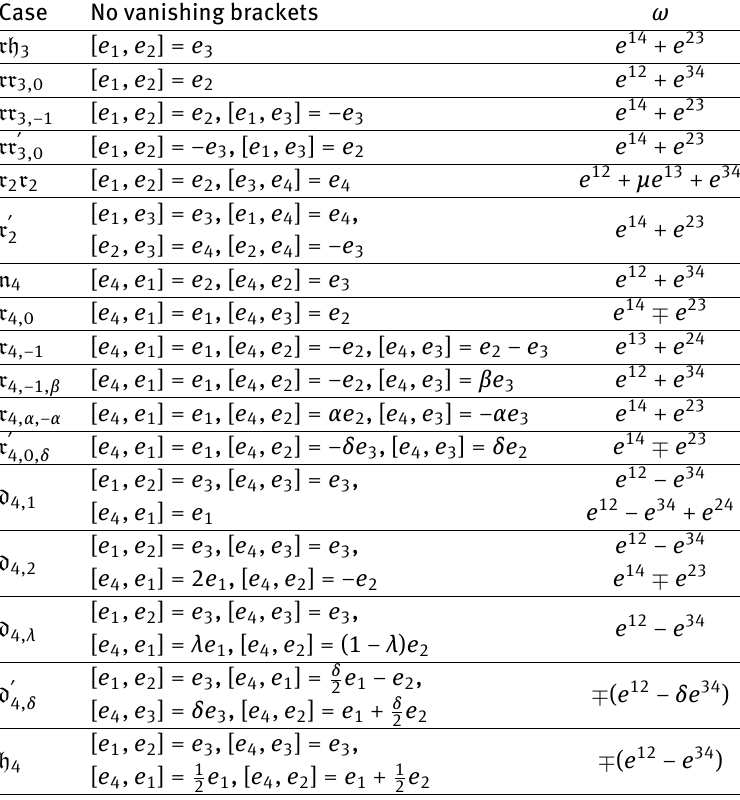
Table 1: Symplectic four-dimensional Lie